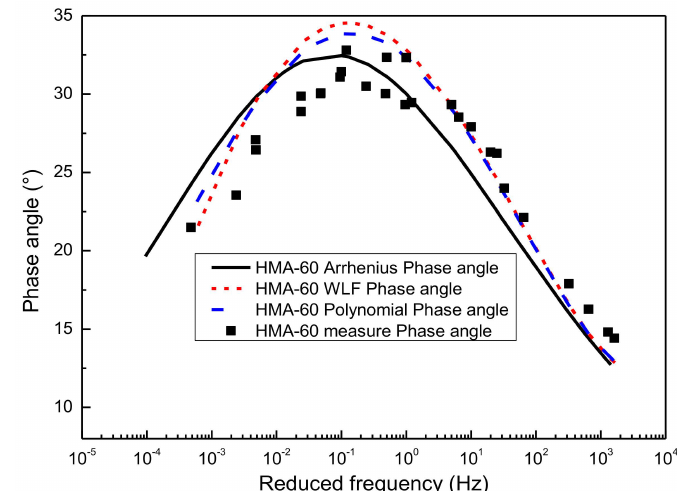
Figure 13. Predict phase angle master curve of HMA-60 from generalized